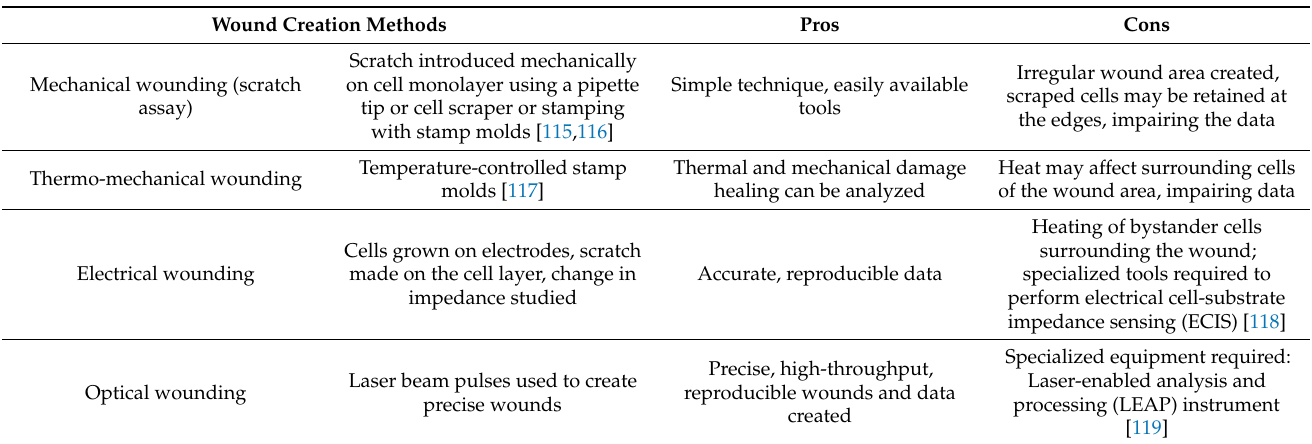
Table 4. Strategies for validation of wound-healing